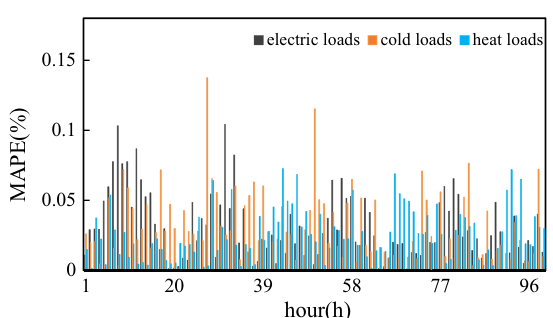
Fig. 6 Distribution of hourly MAPE